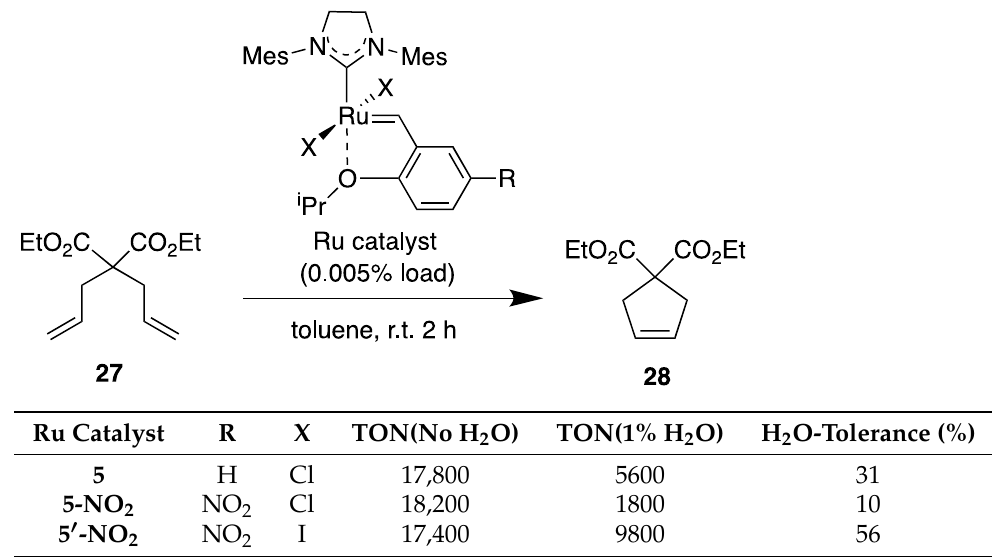
Table 2. Dependency of ligands on water tolerance in the RCM activities of HG-II-type complexes Dependency of ligands on water tolerance in the RCM activities of HG-II-type [55] complexes [55].